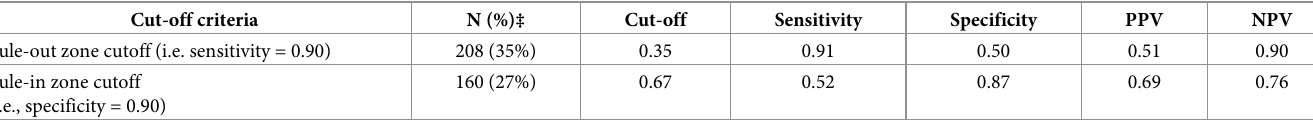
Table 2. Diagnostic statistics of FAST ™ � for at-risk NASH†. Cut-off criteria N (%)‡ Cut-off